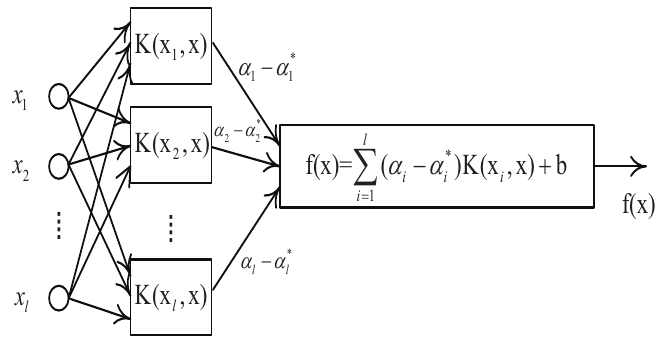
Figure 14. The structure of Support Vector Regression